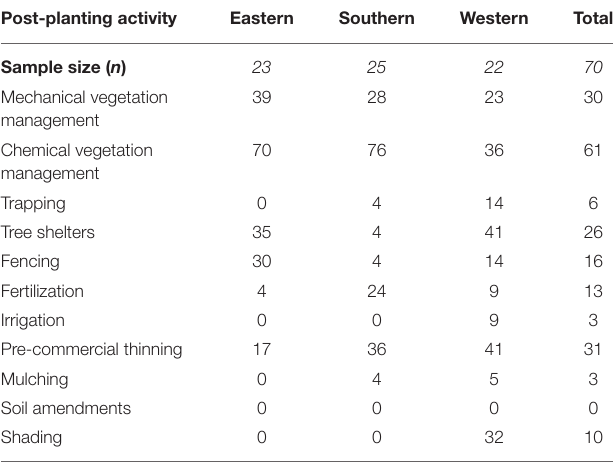
TABLE 1 | Percentage of foresters implementing various outplanting activities in a typical reforestation effort by US region. Outplanting activity